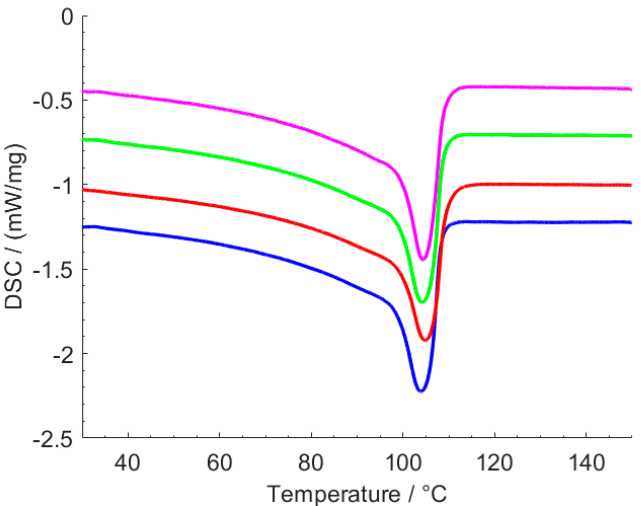
Figure 5. DSC thermograms for (from top to bottom) neat LDPE, LDPE containing 1.5 wt.% TiO 2 , 1.5